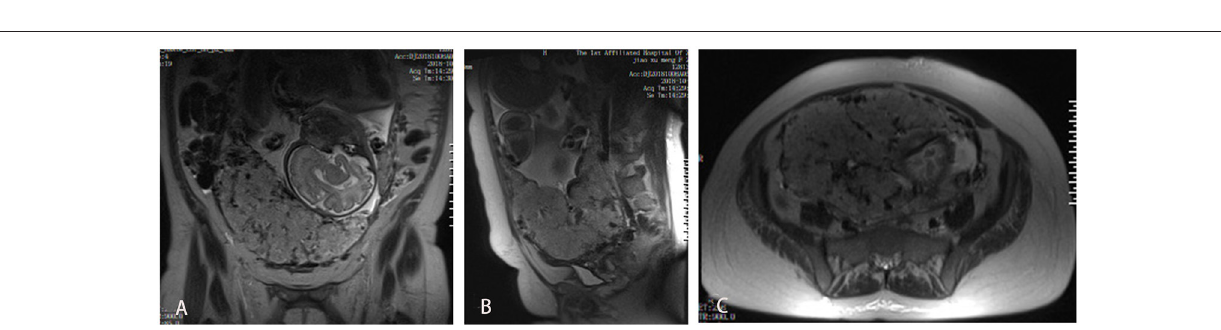
FIGURE 2 | MRI images of the participant. (A) MRI coronal plane on T2-weighted images, showing thickened placenta, heterogeneous signal intensity; (B) MRI sagittal plane, showing unclear boundary of placenta and uterine wall; (C) MRI cross section, showing focal interruption of